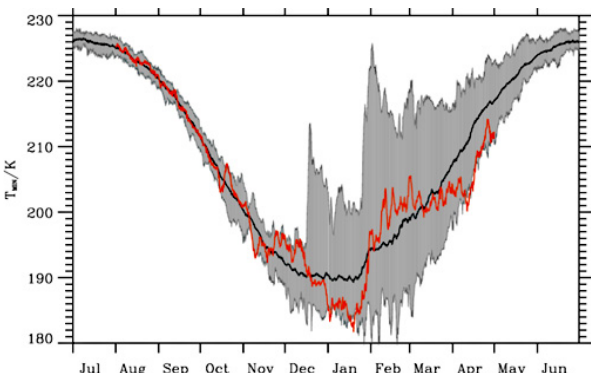
Fig. 4. Minimum temperatures T MIN (K) between 65 ◦ N to 90 ◦ N at the 30hPa pressure surface. Black line: mean value from 1989– 2009; red line the T MIN evolution from August 2009 through April 2010; shaded area encompasses the minimum/maximum T MIN between 1989 and 2009. Source: ECMWF reanalyses interim (ERA interim) data provided at 6 hourly temporal resolutions, see: